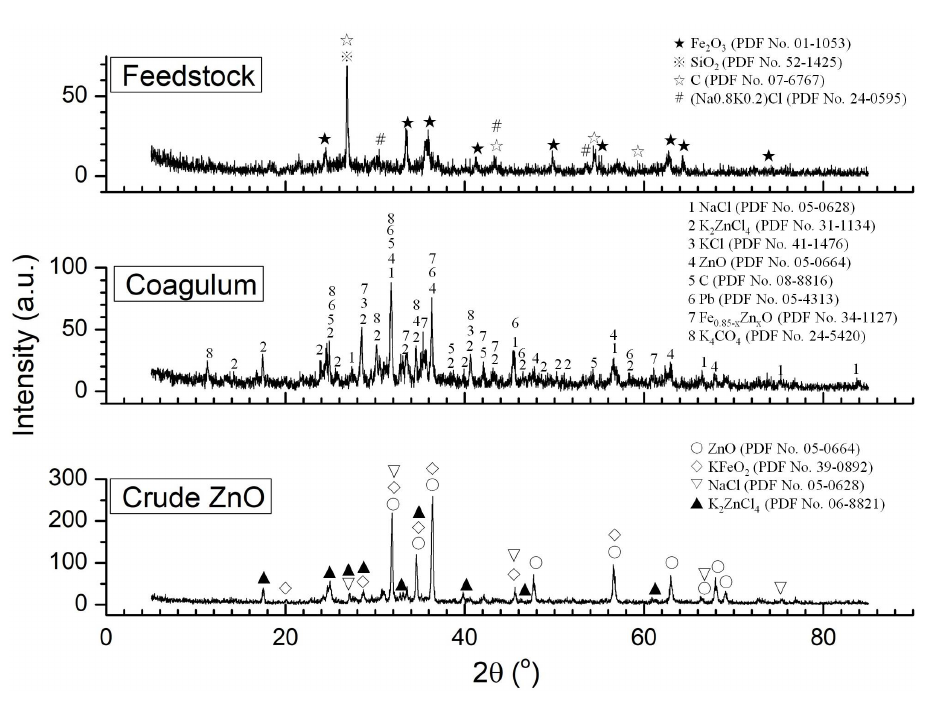
Figure 5. XRD patterns of feedstock, coagulum, and crude zinc powder.